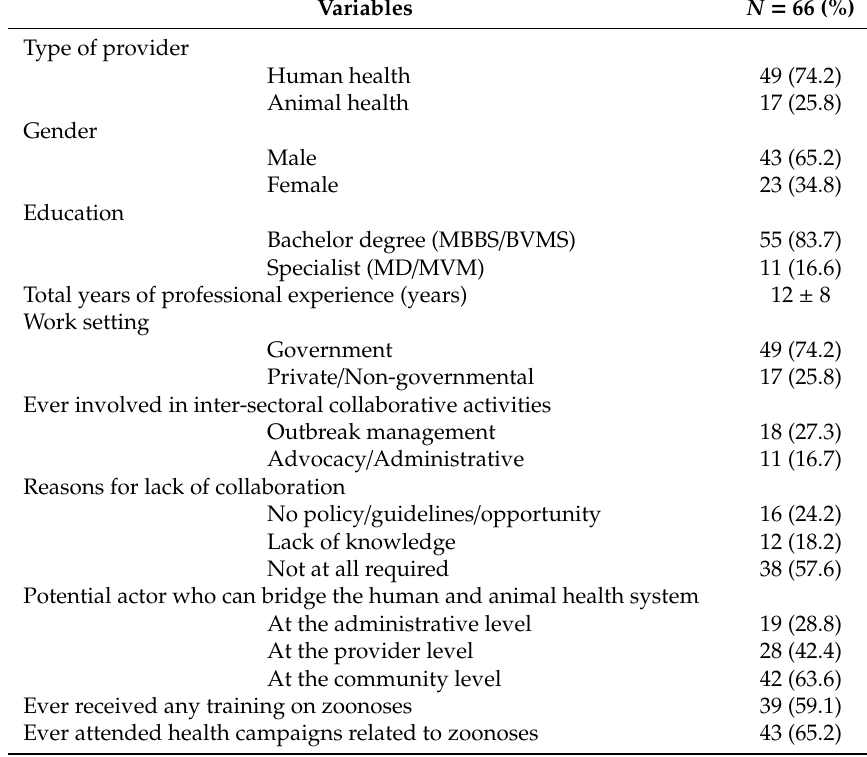
Table 3. Characteristics and collaboration details among the actors at the provider level especially physicians and veterinarians of Ahmedabad,